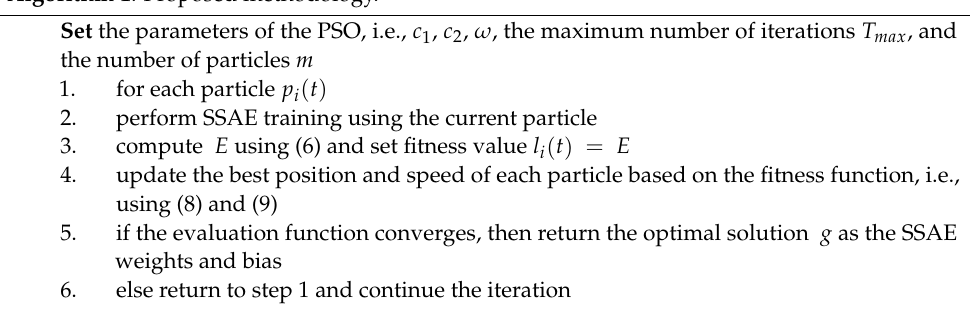
Algorithm 1 . Proposed methodology.